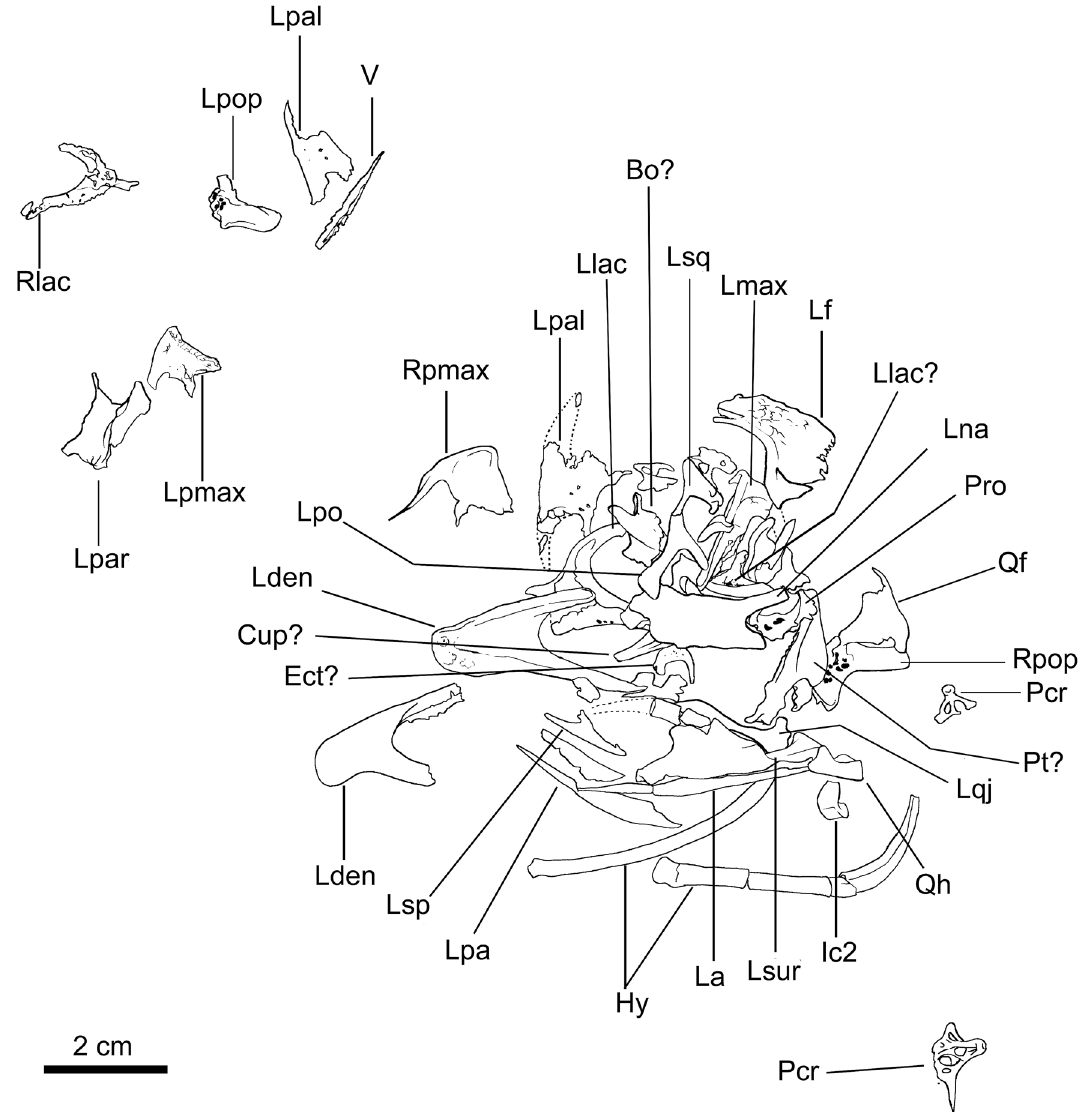
Figure 1. Berthasaura leopoldinae gen. et sp. nov . holotype (MN 7821-V), line drawing of the skull and mandible. Abbreviations: Bo? basioccipital fragment; Cup?, cutriform process; Ect? ectoperygoid; Hy, hyoids; Ic2, intercentrum 2; La, left angular; Lden, left dentary; Lf, left frontal; Llac, left lacrimal; Llac?, left lacrimal fragment; Lmax, left maxilla; Lna, left nasal; Lpa, left prearticular; Lpal, left palatine; Lpo, left postorbital; Lpar, left parietal; Lpmax, left premaxilla; Lpop, left paraoccipital process; Lqj, left quadratojugal; Lsp, left splenial; Lsq, left squamosal; Lsur, left surangular; Pcr, proximal fragment of cervical rib; Pro, prootic fragment; Pt?, pterygoid; Qf, quadratic flange (pterygoid flange of the quadrate); Qh, quadratic head; Rden, right dentary; Rlac, right lacrimal; Rpop, right paraoccipital process; Rpmax, right premaxilla. Line drawing by